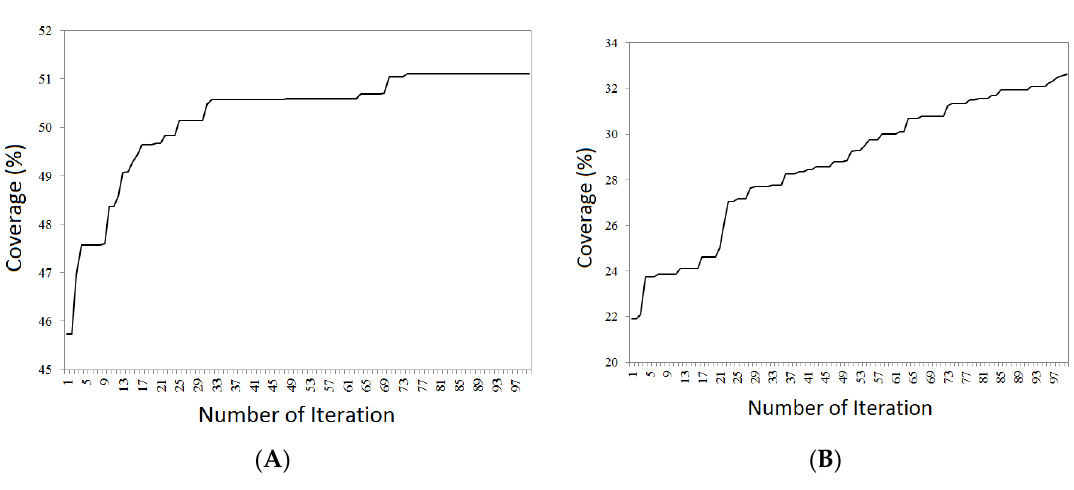
Figure 10. Convergence diagram of probability coverage based on genetic algorithm for raster models in 100 cm resolution: ( A ) two-dimensional; and ( B ) three-dimensional.